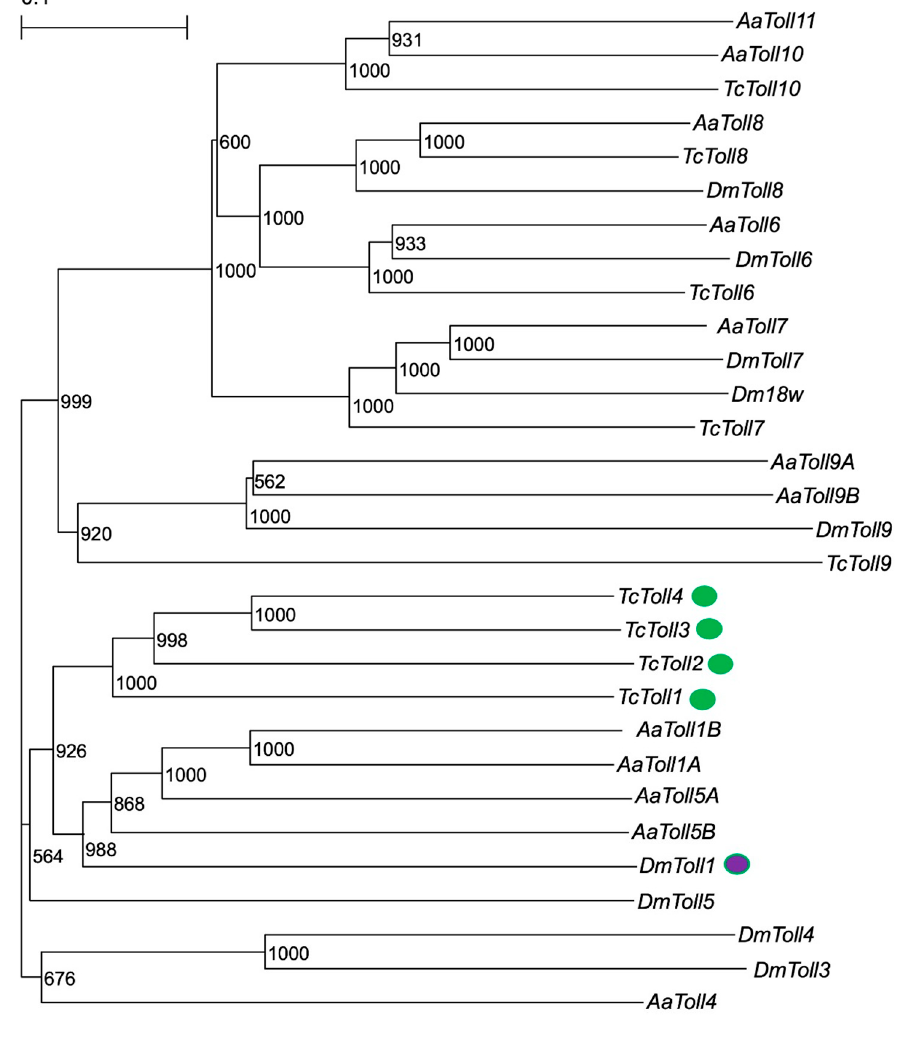
Figure 1. Phylogenetic analysis of T. castaneum Toll (TcToll), D. melanogaster Toll (DmToll), and A. aegypti Toll (AaToll). The accession IDs of the Toll sequences used in the tree are shown in Supplemental Table S1. Numbers on branches indicates bootstrap values. Purple and green objects indicate Dm-Toll1 and Tc-Toll1−4, respectively.